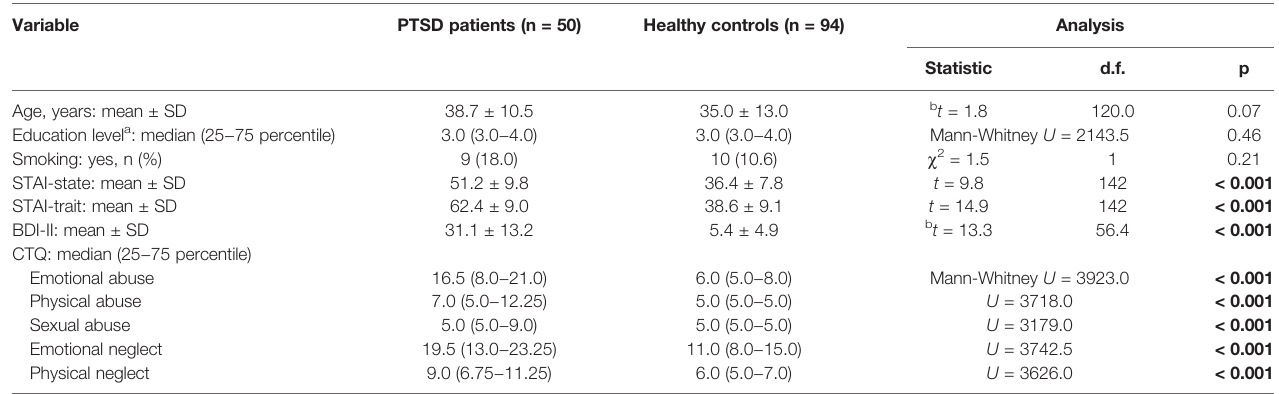
TABLE 1 | Demographic and psychological characteristics in PTSD patients and healthy controls.